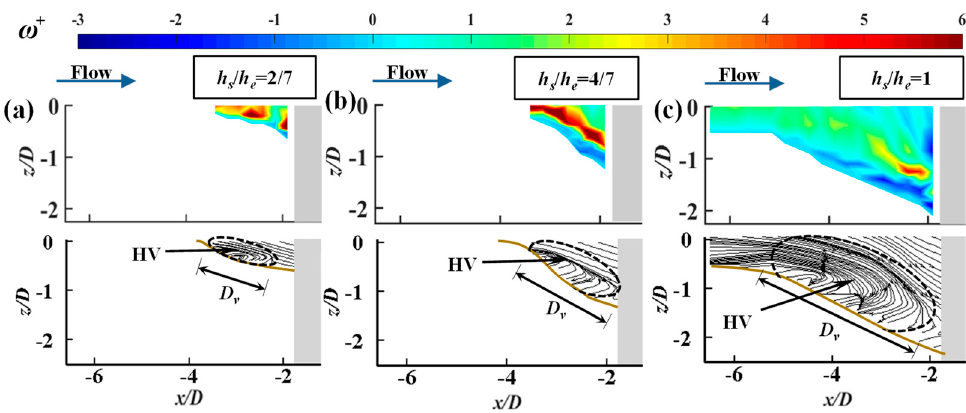
Figure 6. Contours of vorticity ω + and streamlines upstream of the symmetry plane within developing scour holes for ( a ) h s / h e = 2/7, ( b ) h s / h e = 4/7, and ( c ) h s / h e = 1.